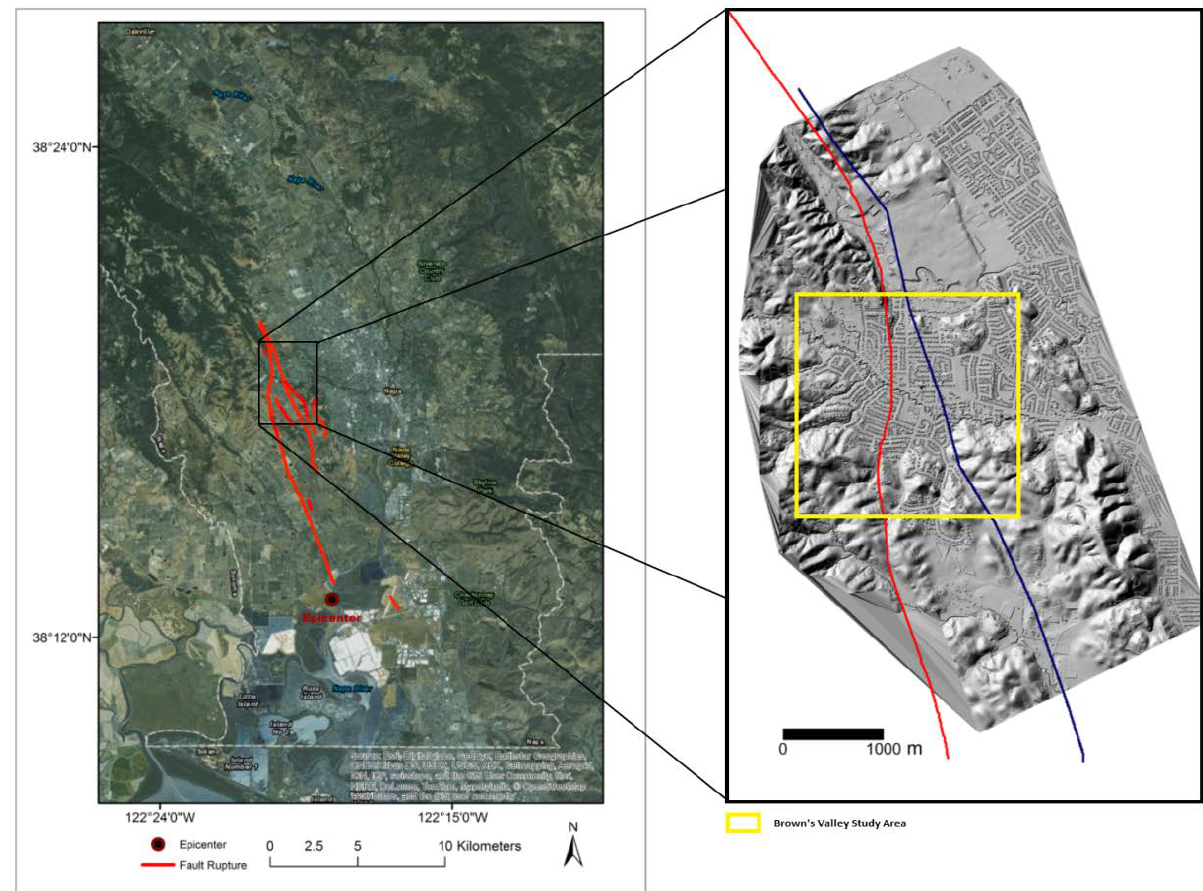
Figure 1. Map of field identified earthquake traces (red) in the Napa Valley after South Napa earthquake. Right inset shows DTM of the Browns Valley Neighborhood with buildings added. Yellow box shows area of detailed analysis for this study. Red line through inset represents the primary fault trace A and blue line represents the fault trace C (Hudnut et al.,